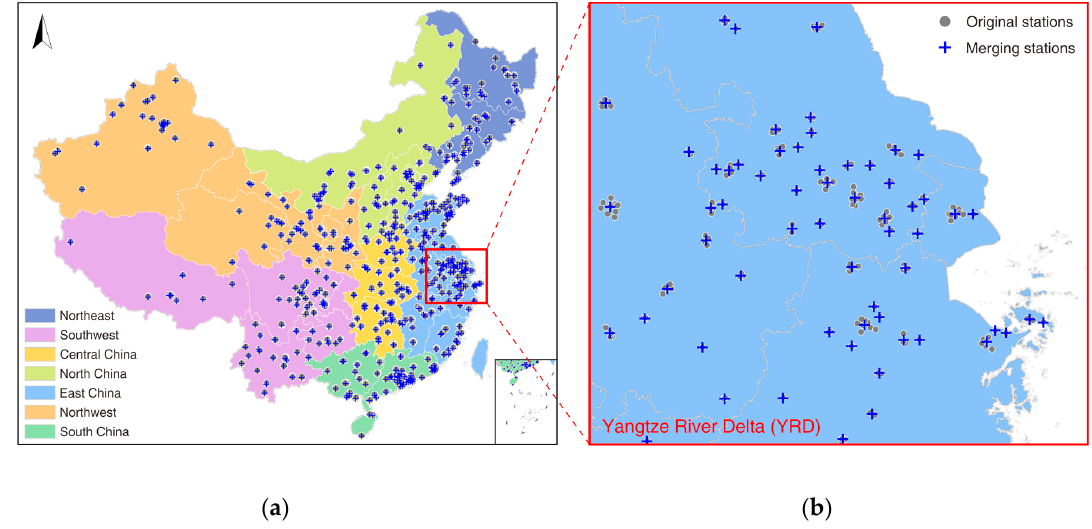
Figure 1. The seven major Chinese geographic divisions ( a ) and an illustrative example of spatial hierarchy clustering ( b ). Gray dots represent the original monitoring stations and blue crosses denote the aggregated stations after spatial clustering.